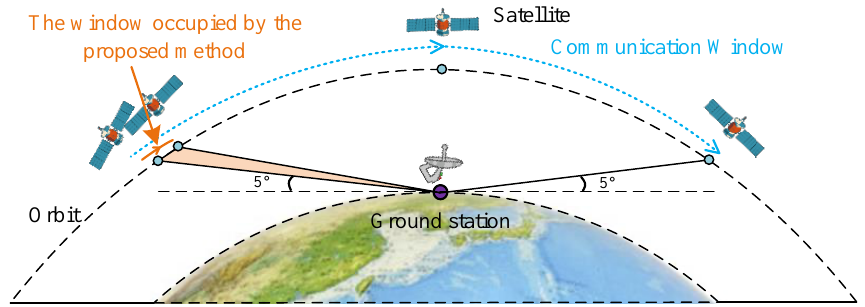
Figure 10. The communication window occupied by the proposed